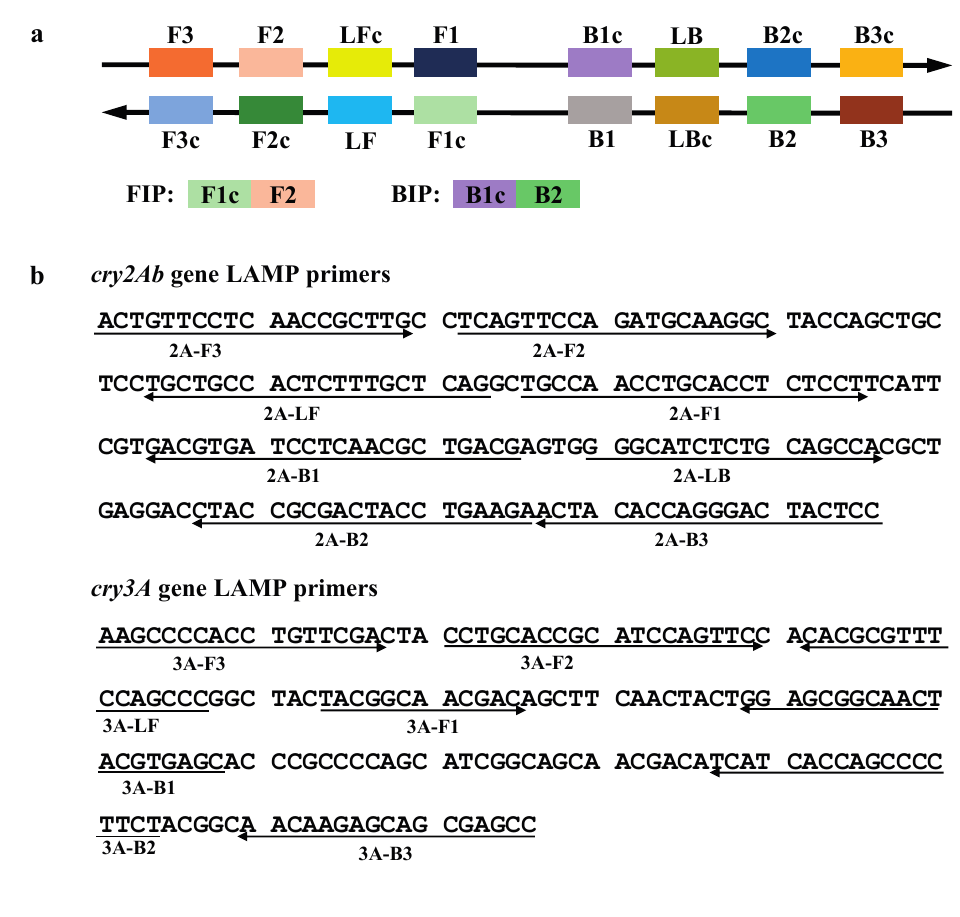
Figure 1. Primer design for loop-mediated isothermal amplification (LAMP) assays. ( a ) The schematic diagram showing the location of each primer; and ( b ) Partial coding sequences of the cry2Ab and cry3A genes used to design the primers. LAMP primers are indicated by